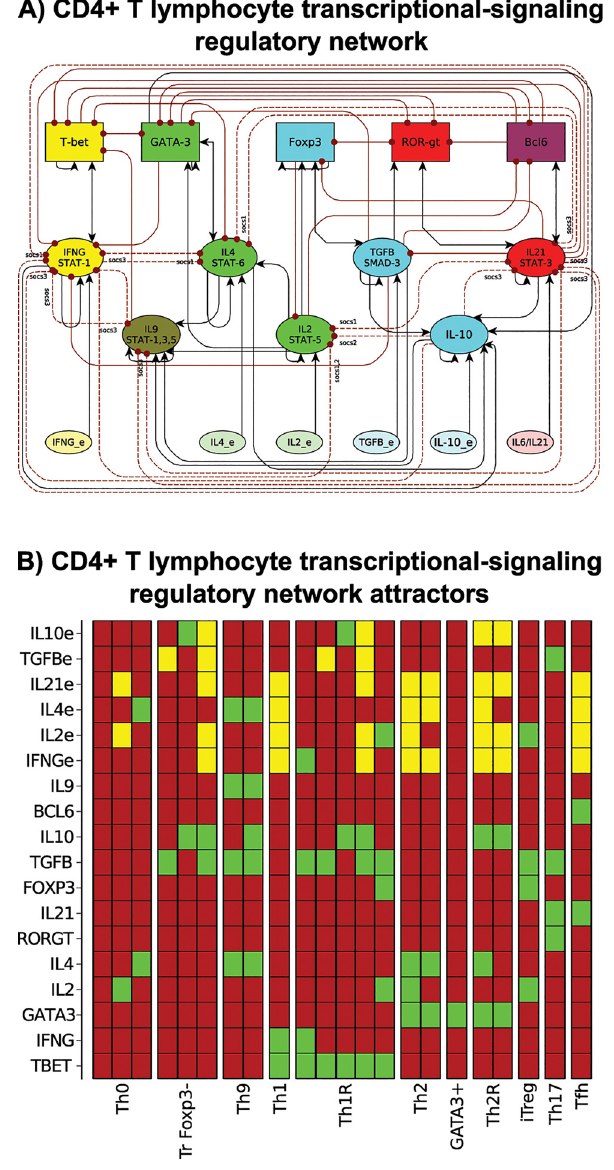
Fig 3. CD4+ T cell transcriptional-signaling regulatory network (TSRN). We constructed a regulatory network using available experimental data. The network includes transcription factors, signaling pathways, and intrinsic and extrinsic cytokines. (A) Graph of the TSRN. The nodes include transcription factors (rectangles), intrinsic cytokines and their signaling pathways (ellipses) and extrinsic cytokines (ellipses). Node colors correspond to cell type: Th1 (yellow), Th2 (green), Th17 (red), iTreg (blue), Tfh (purple), and Th9 (brown). Activations between elements are represented with black arrows, and inhibitions with red dotted arrows. The dotted lines represent inhibition mediated by SOCS proteins. (B) Attractors of the TSRN. Each column corresponds to an attractor. Each node can be active (green) or inactive (red), extrinsic cytokines may be active or inactive (yellow). The following attractors were found in the network: Th0, Th1, Th2, Th17, iTreg, Tfh, Th9 producing T cells, Foxp3-independent T regulatory cells (TrFoxp3-), T-bet+ T regulatory cells (Th1R), GATA3+ T regulatory cells (Th2R) and GATA3+IL-4- cells. Attractors where labeled according to the active transcription factors and intrinsic cytokines.